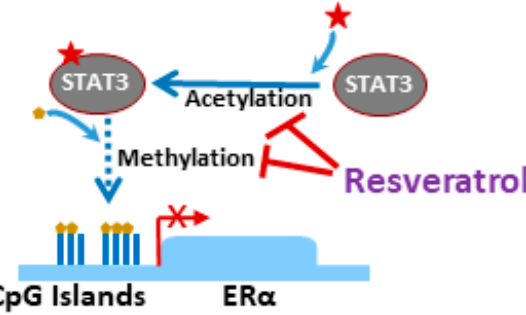
Figure 3. Epigenetic regulation in triple negative breast cancers (TNBCs). TNBCs are characterized by activated STAT3 signaling, involving acetylated STAT3. ER α signaling in TNBCs is silenced through promoter DNA hypermethylation which might be related to STAT3 acetylation but the mechanisms remain unclear (and are therefore shown with a dotted line). Resveratrol is an effective inhibitor of STAT3 acetylation as well as ER α promoter DNA methylation. Restoration of ER-signaling makes TNBC cells sensitive to the ER-targeting therapy, tamoxifen.